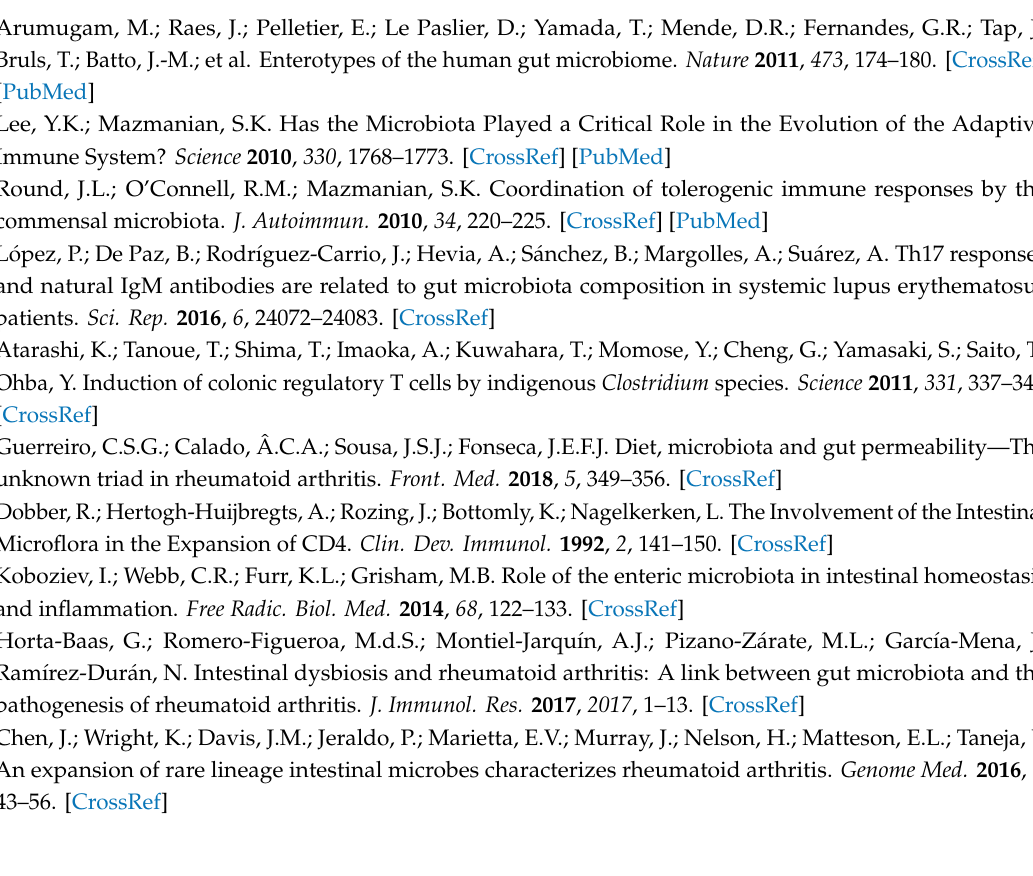
s1. Figure S1: PCoA plot analysis ( β -diversity) revealed the microbial profile distances were not significantly di ff erent(A)betweenmethotrexate(MTX)-treatedgroupandnoMTX-treatedgroupor(B)betweenbiologics-treated group and no biologics-treated group among RA patients. Blue dots: treatment with MTX or biologics; orange dots: treatment without MTX or